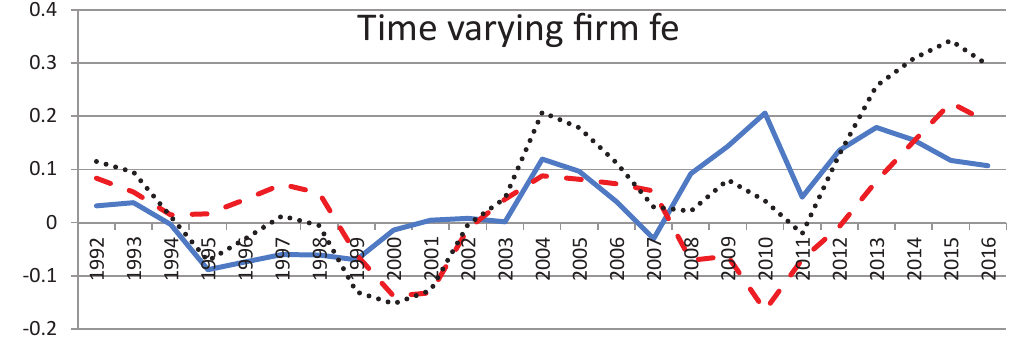
Figure A5 Contribution of composition effects to the wage growth, distinguishing between employers’ and workers’ characteristics and different types of fixed